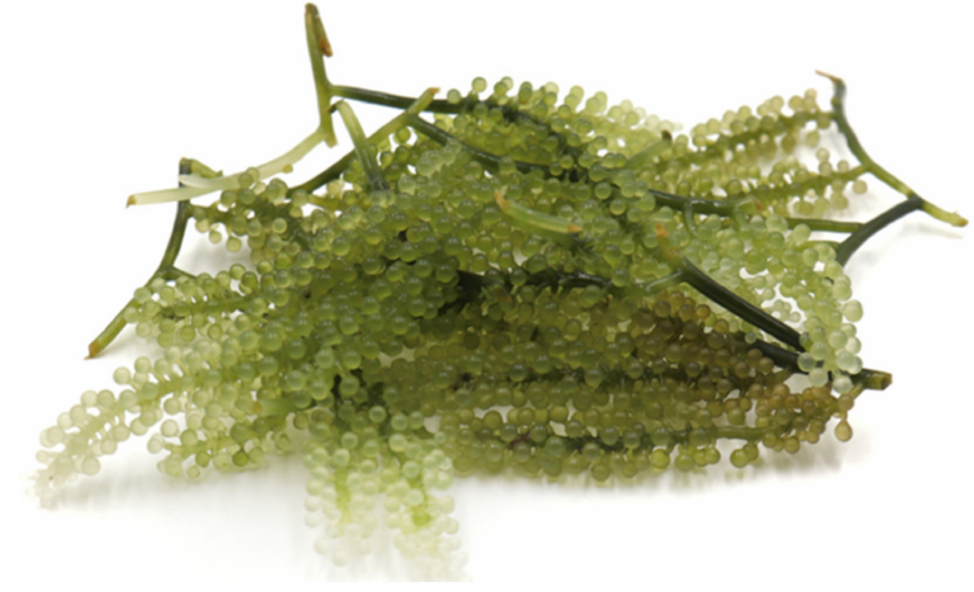
Figure 1. Fresh C. lentillifera